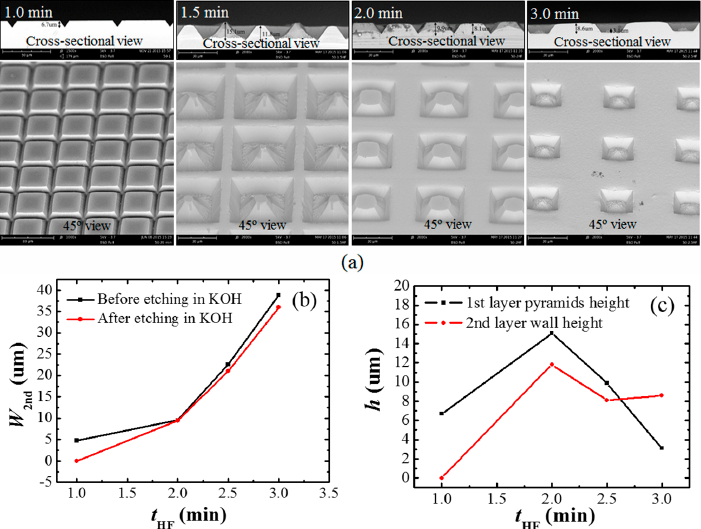
Figure 3. ( a ) SEM images of the fabricated structures at different t HF (top: cross-sectional view, bottom: 45 ˝ view). ( b ) The second layer wall width ( W 2nd ) varies with t HF . ( c ) Height ( h ) of the first layer micropyramids and the second layer walls changes with t HF . The sample patterns are 50 µ m ˆ 50 µ m square with gap distance of 5 µ m. The samples were etched in HF solution for 1.0, 1.5, 2.0 and 2.5 min. All sample substrates were etched in 10 wt % KOH solution for 30 min at 70 ˝